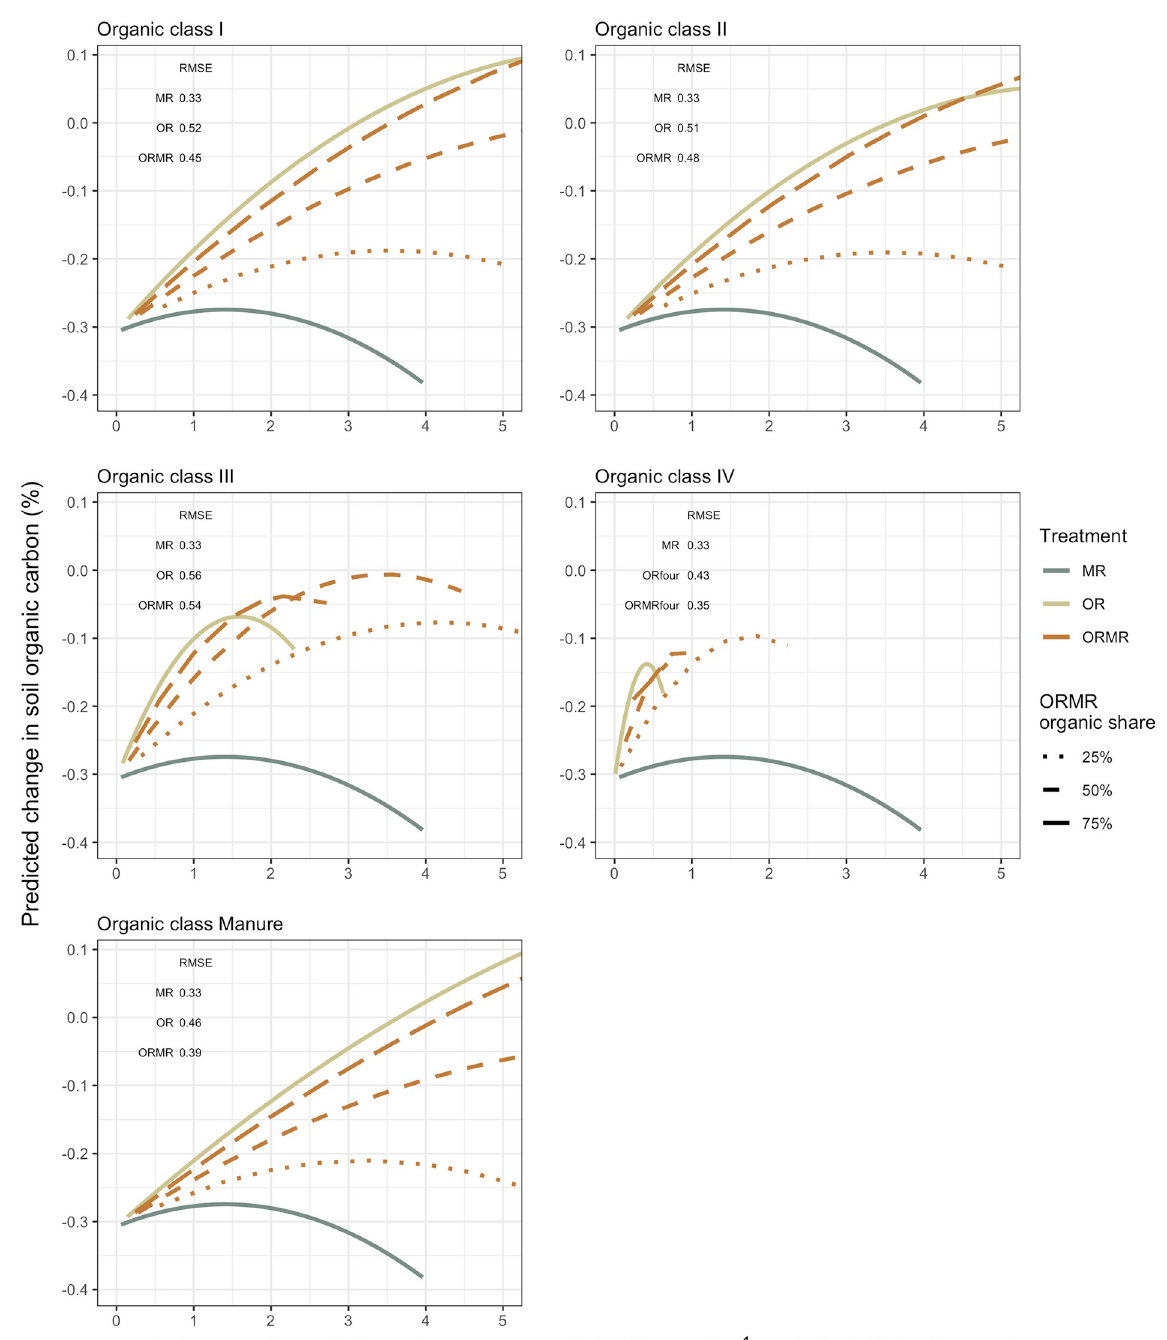
Fig 9. The output of the N-SOC model is used to predict changes in soil organic carbon from its initial values (dSOC) across the cumulative total N input rates (t ha -1 ), applied as mineral or organic fertilizer and for which data are available, but limited to five cumulative t N ha -1 . They are plotted at a data base average initial SOC of 1.8% and separately for each organic class and ORMR with different proportions of organic N content. The root mean square error (RMSE, in %) is given for the different predicted dSOCs from treatments with the respective organic